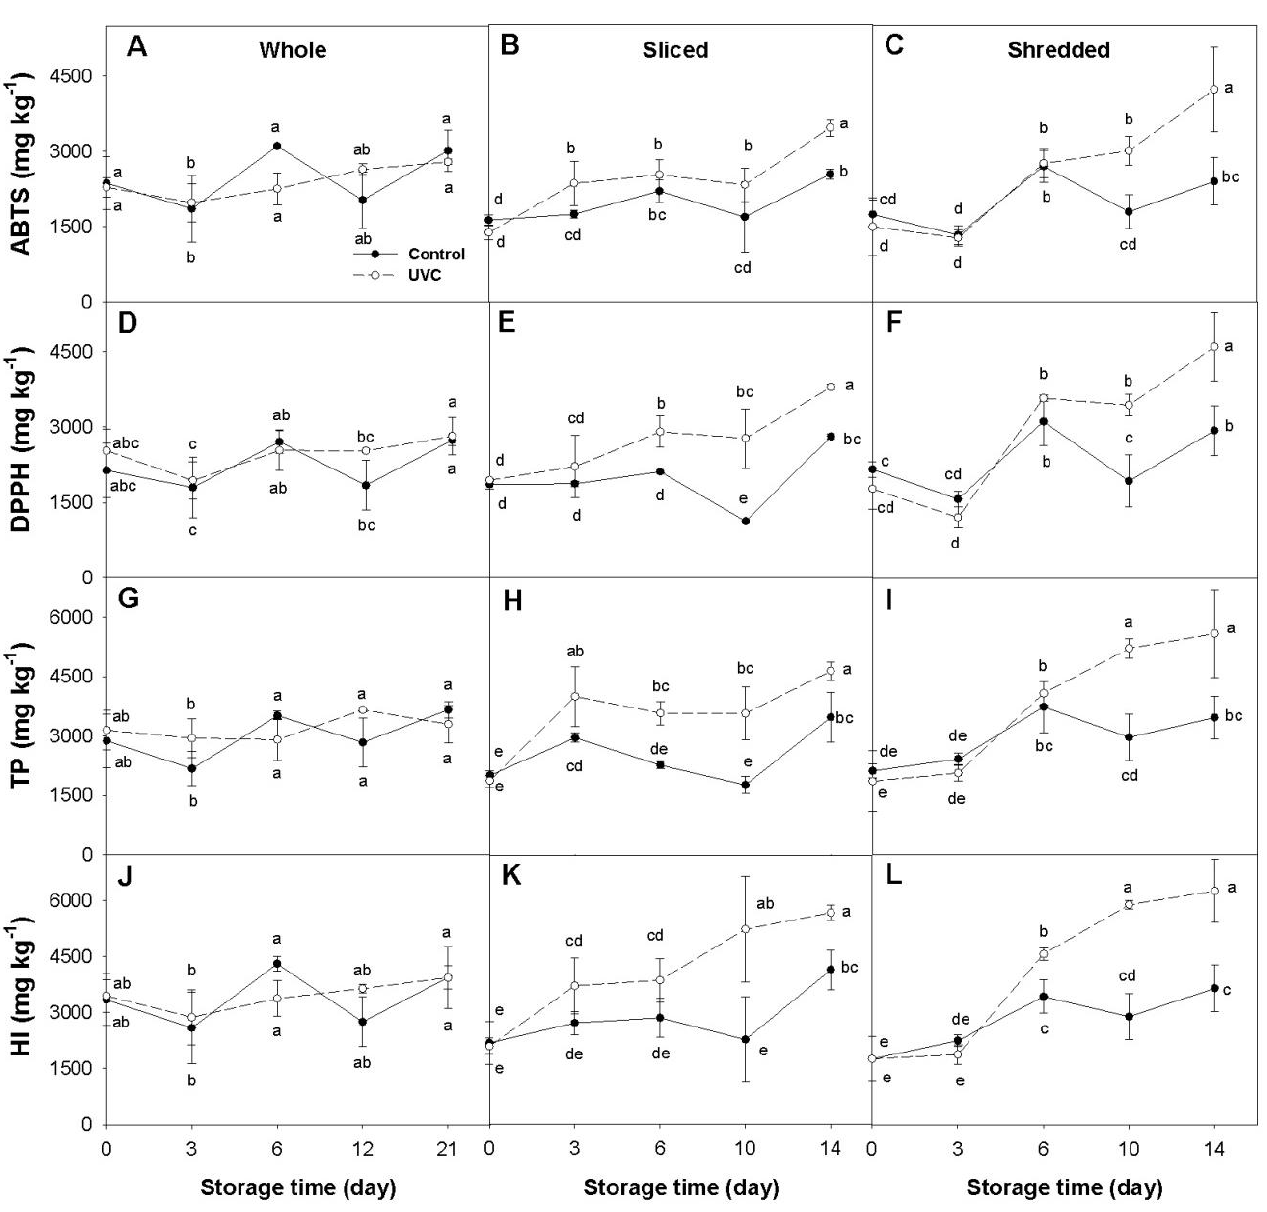
Figure 4. Time-course variation for mean antioxidant capacity determined by the ABTS ( A – C ) and DPPH ( D – F ) methods, concentration of total phenolics (TP) ( G – I ), and hydroxycinnamic index (HI) ( J – L ) for whole ( A , D , G , J ), sliced ( B , E , H , K ), and shredded ( C , F , I , L ) root samples of the purple-rooted inbred line ‘INTA44′ during cold storage at 5 °C. Antioxidant capacity is expressed as mg Trolox equivalents per kg fw, whereas TP, HI, and anthocyanin concentrations are expressed as mg × kg -1 fw. Error bars represent standard deviation of the mean. Means not sharing a common letter are significantly different at p < 0.05, Fisher test.